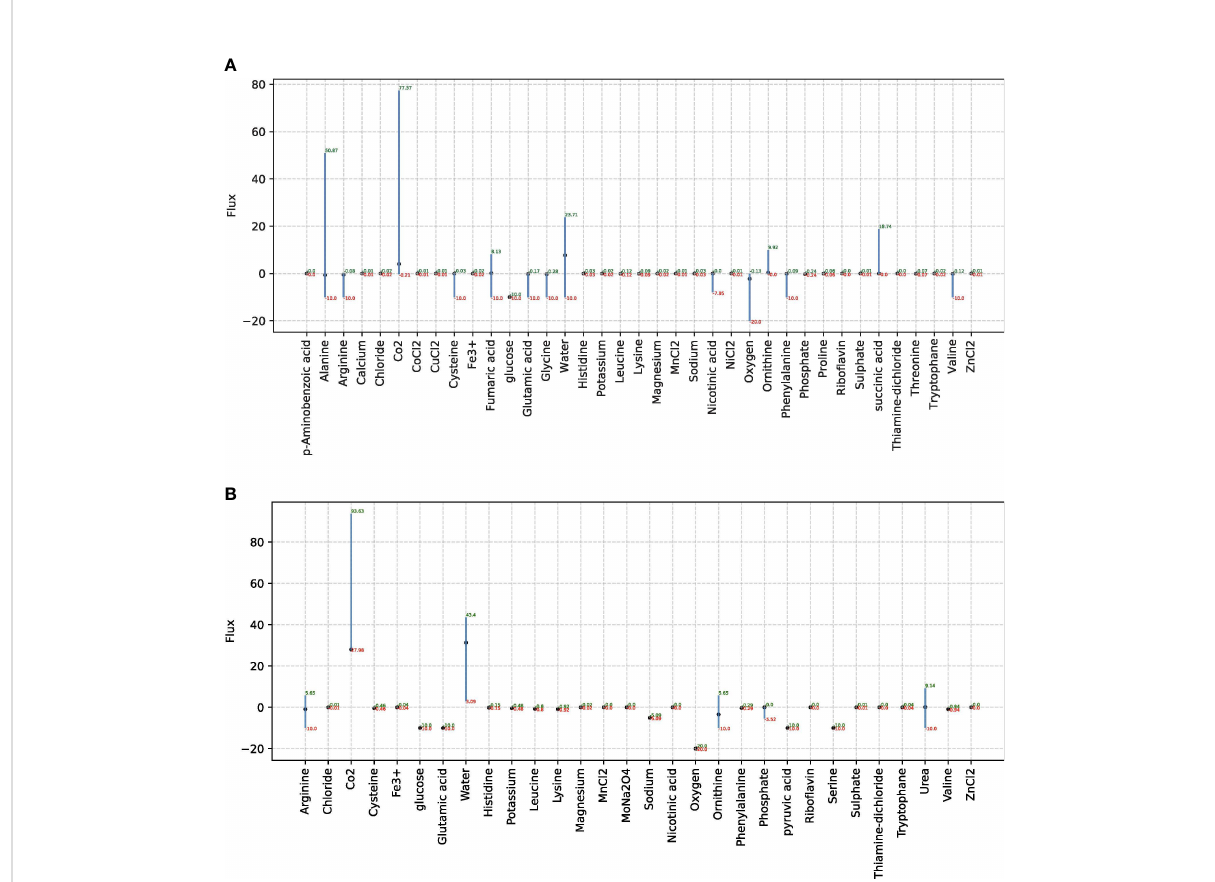
FIGURE 2 The FVA results for non-zero exchange reactions in species D. pigrum and S. aureus . In each plot, only non-zero exchange reactions that can take place in SNM3 are taken into account. FVA returns the boundaries for the fl uxes through each reaction that can, paired with the right combination of other fl uxes, estimate the MBR. Reactions that can support a low variability of fl uxes through them are likely to be of higher importance to an organism and FVA is a promising technique for the identi fi cation of important reactions. The x -scale in each plot shows the associated metabolites that considered exchange reactions and the y -scale shows the respective fl ux for the related exchange reaction. (A) Is associated with D. pigrum while (B) Stands for the species S.